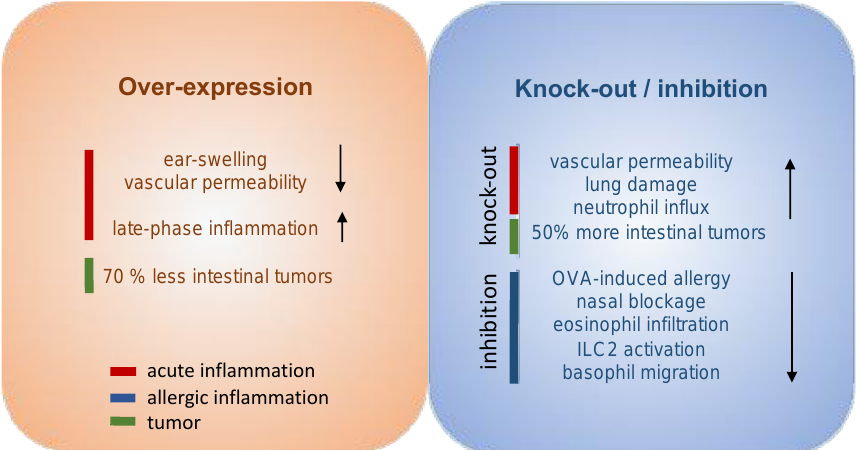
Figure 3. Experimental overexpression, inhibition and knock-out of hPGDS differentially modulates acute and chronic inflammation. Overexpression of transgenic hPGDS in mice resulted in reduced ear swelling and vascular permeability in the acute phase of inflammation, however, it exacerbated leukocyte influx in the late phase; In the same model, hPGDS knock-out potentiated vascular extravasation during acute skin inflammation [12]. Neutrophil influx and lung damage was more prominent in hPGDS knock-out mice [14]. In contrast, hPGDS inhibition proved to be beneficial in experimental models of allergic inflammation [28,119,120]. Interestingly, hPGDS over-expression was able to reduce the number of intestinal tumors, while hPGDS knock-out showed the opposite effect [27].